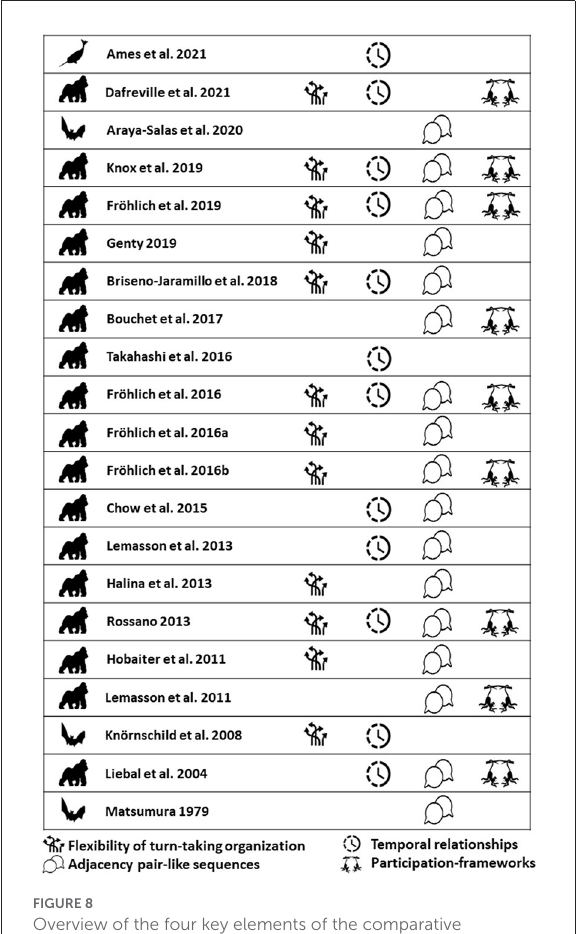
FIGURE8 Overview of the four key elements of the comparative framework proposed by Pika et al. (2018) to enable systematic comparisons across